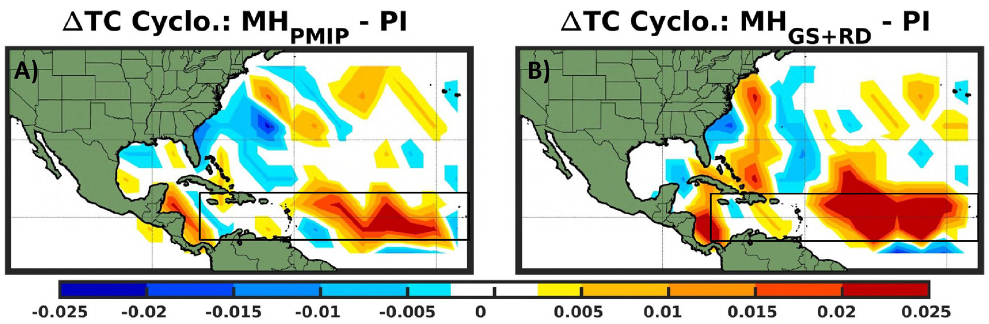
Figure 4. TC seasonal (JJASON) cyclogenesis density anomaly for (a) MH PMIP and (b) MH GS + RD experiments relative to PI represented over a 5 ◦ mesh-grid Mercator projection. The black box shows the approximate present-day MDR.